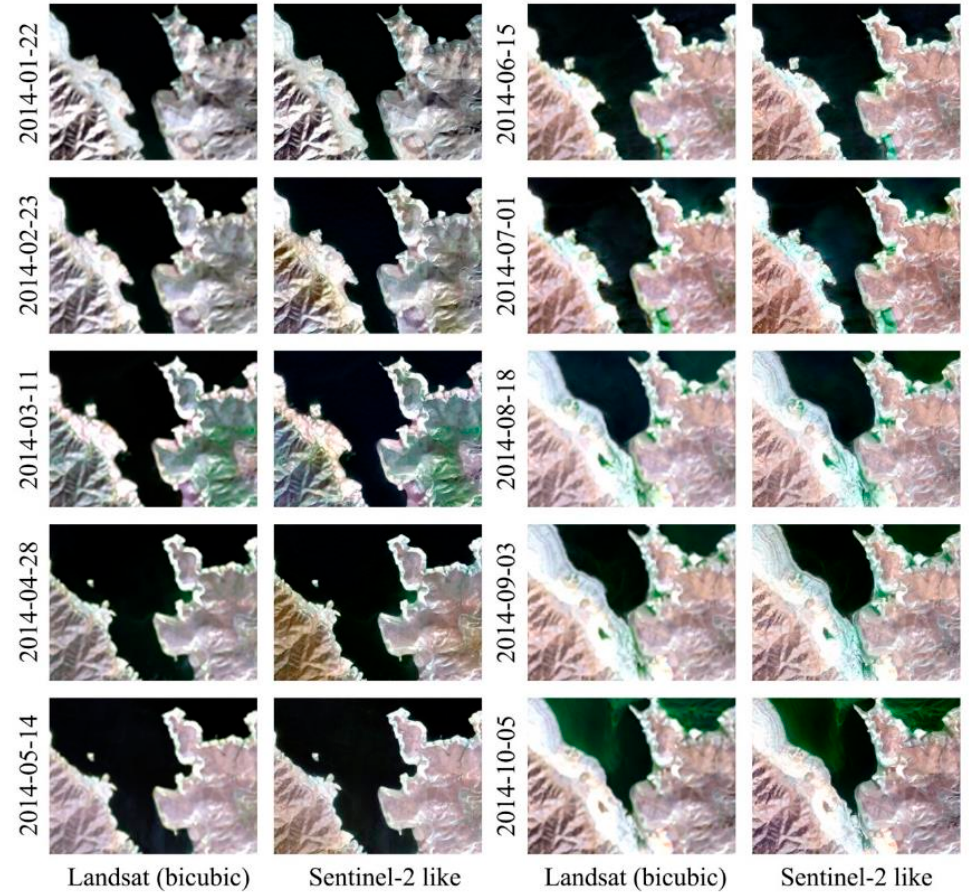
Figure 10. Super-resolution results of time-series Landsat images for capturing water dynamics in California. From left to right: 10 m interpolation derived from Landsat using the bicubic method, and Sentinel-2-like reconstructed image derived from the GAN-based super-resolution.